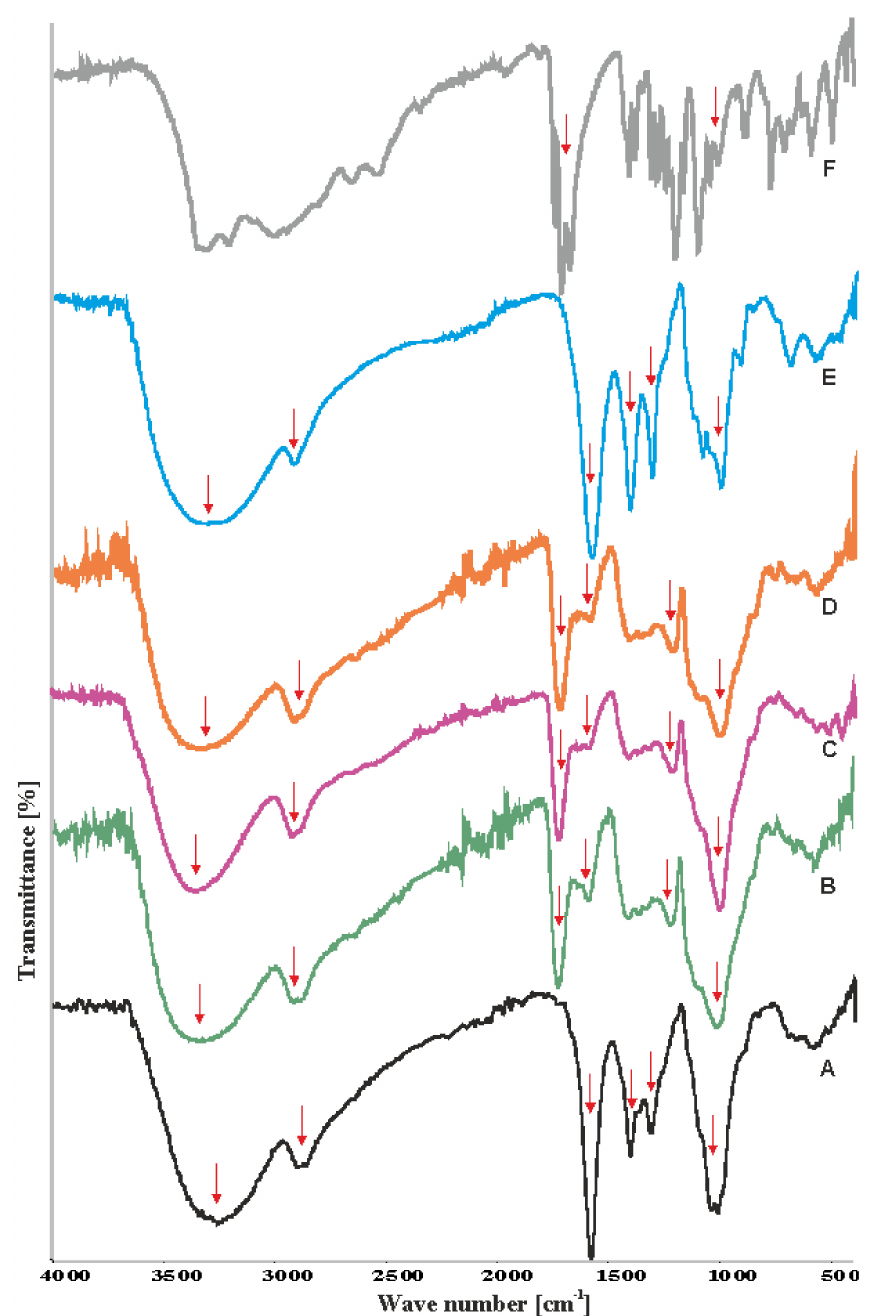
Figure 1. Fourier transform infrared (FTIR) spectra of neat carboxymethyl cellulose (CMC) (curve A), CMS / CMC based films for wt% ratio: 60 / 40 (B), 50 / 50 (C); and 40 / 60 (D), neat carboxymethyl starch (CMS) (E), and citric acid